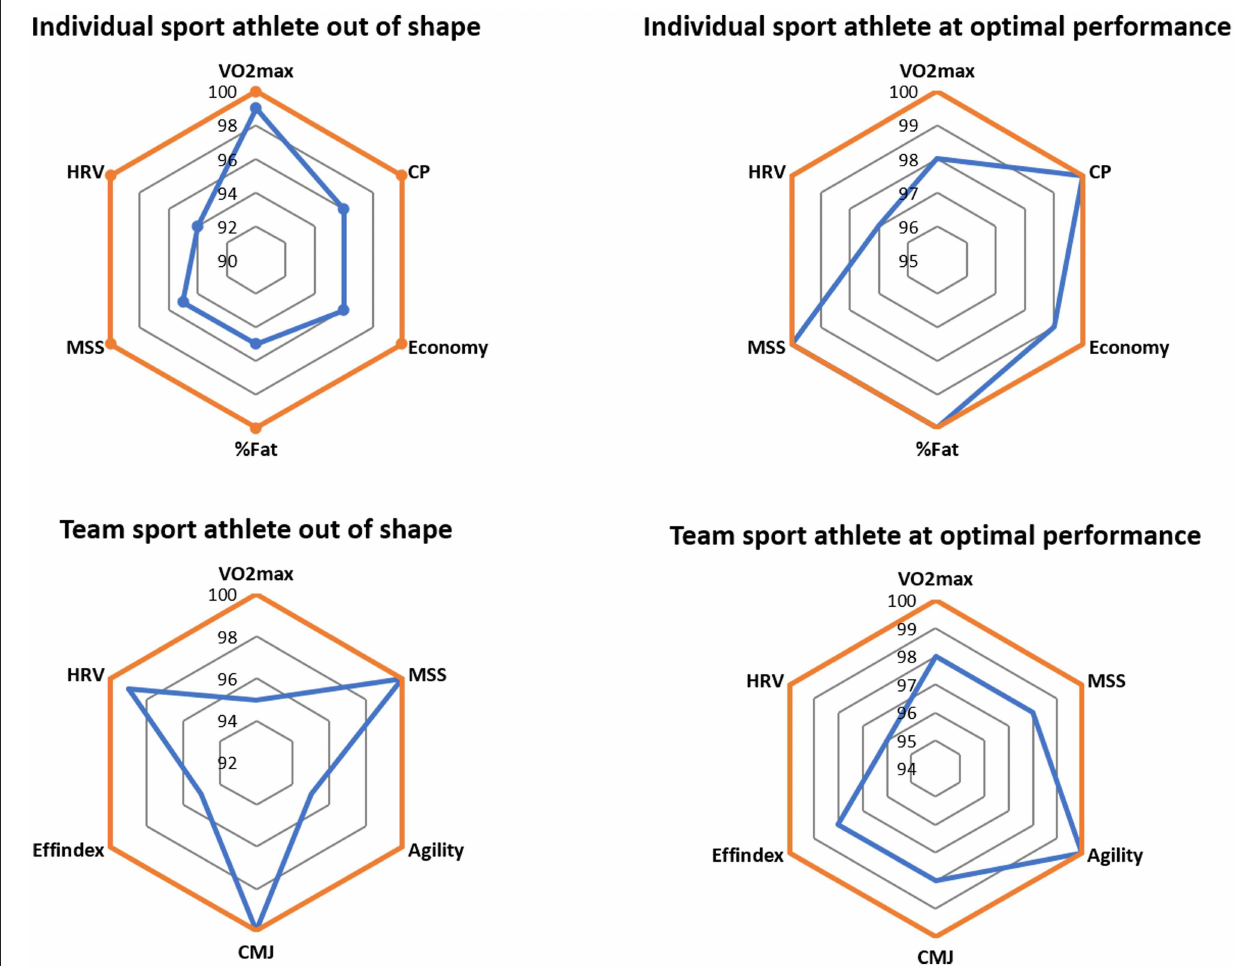
FIGURE 1 | Simulated example of the different evolution of physiological profiles in individual vs. team sports athletes. Note that in individual sports, most physiological parameters tend to be at their maximum individual values (personal best) at optimal performances. In contrast, this is not necessary for optimal performances in team sports. CMJ, countermovement jump; CP, critical power; Effindex, efficiency index; HRV, heart rate variability; MSS, maximum sprinting speed; VO 2 max, maximum oxygen consumption; %Fat, percentage of body